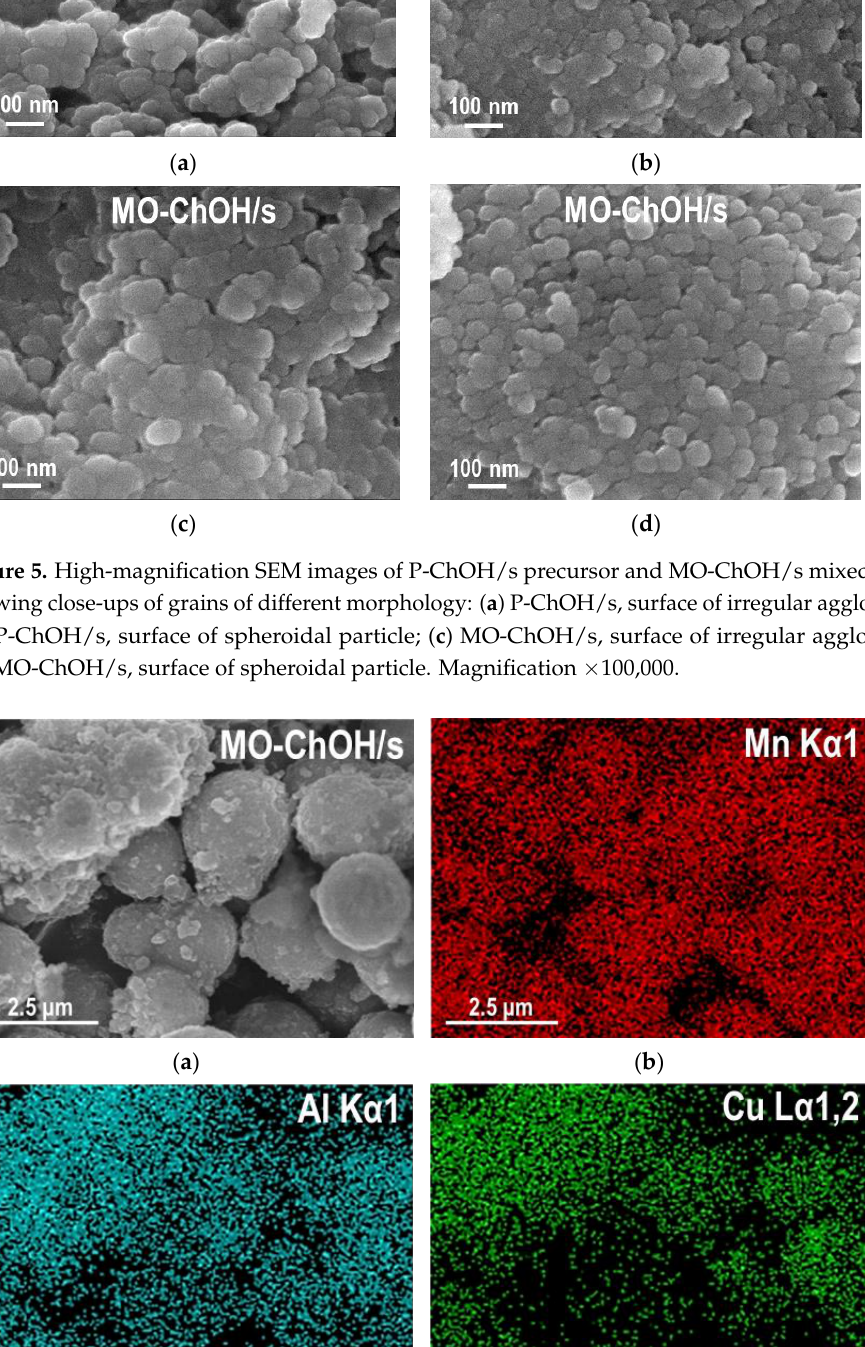
Figure 6. SEM/EDX compositional analysis of selected area of MO-ChOH/s sample: ( a ) SEM image; ( b ) EDX mapping image of Mn; ( c ) EDX mapping image of Al; ( d ) EDX mapping image of Cu. Based on the EDX data, one can conclude that the Cu 1.5 Mn 1.5 O 4 spinel, the major crys- talline phase in the calcined samples, may be present in both types of grains. On the other hand, the amorphous Mn-rich oxide phase, whose presence has been inferred from the XRD data of calcined catalysts, is expected to be located chiefly within the spherical grains, which contain a surplus of Mn with respect to spinel composition. In contrast, in irregular particles, it is copper that is in excess of spinel stoichiometry. Therefore, it may be pre- sumed that crystalline CuO, detected in the biotemplated samples, is present within the irregular agglomerates, intimately intermixed with particles of different composition. Aluminum may contribute to all crystalline and amorphous phases, but it is preferentially located within the irregular agglomerates, most likely as amorphous alumina. 2.1.3. FTIR Analysis In accordance with the results of the XRD analysis, the FTIR spectra of both series of synthesized solids display bands characteristic of rhodochrosite, marked in Figure 7 by dashed vertical lines. The bands stem primarily from fundamental vibrations of the car- bonate anion, i.e., the in-plane symmetric C–O stretching mode (ν 1 ), the CO 3 out-of-plane bending (ν 2 ), the asymmetric C–O stretching (ν 3 ), and the in-plane CO 3 bending (ν 4 ) [59]. The wavenumbers determined for each mode are given in the spectrum of P-NaOH. Thus, the low-intensity feature at 1075 cm −1 corresponds to ν 1 ; the sharp, intense band at 861 cm −1 is due to ν 2 ; the broad, intense band at 1452 cm −1 stems from ν 3 ; and the narrow band at 726 cm −1 is related to ν 4 . It should be noted that in crystalline MnCO 3 , the carbonate